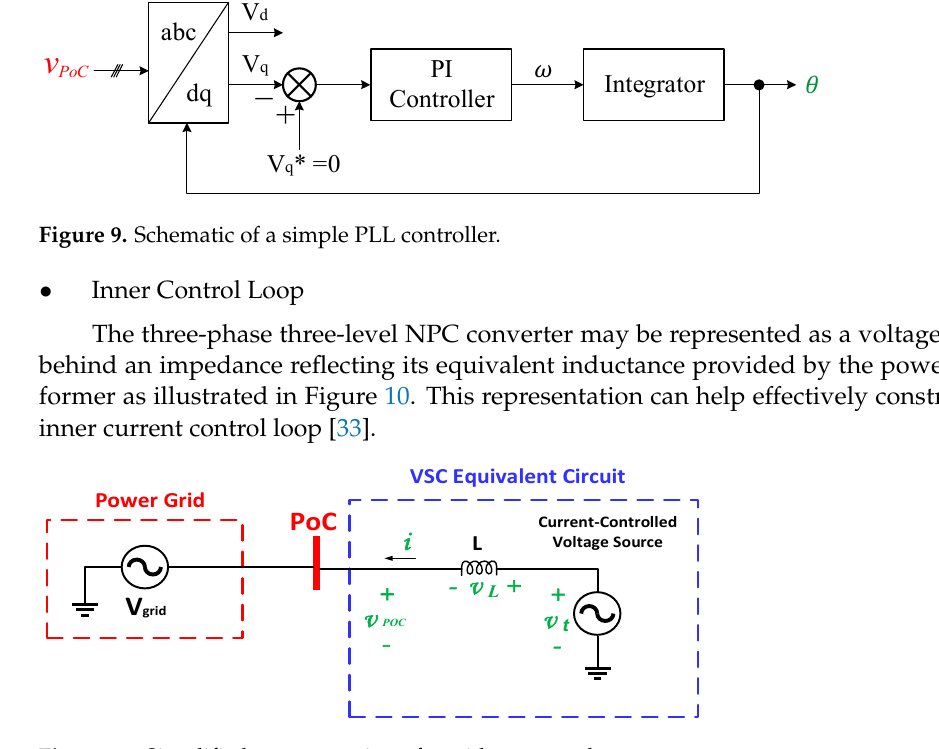
Figure 10. Simplified representation of a grid-connected power converter.